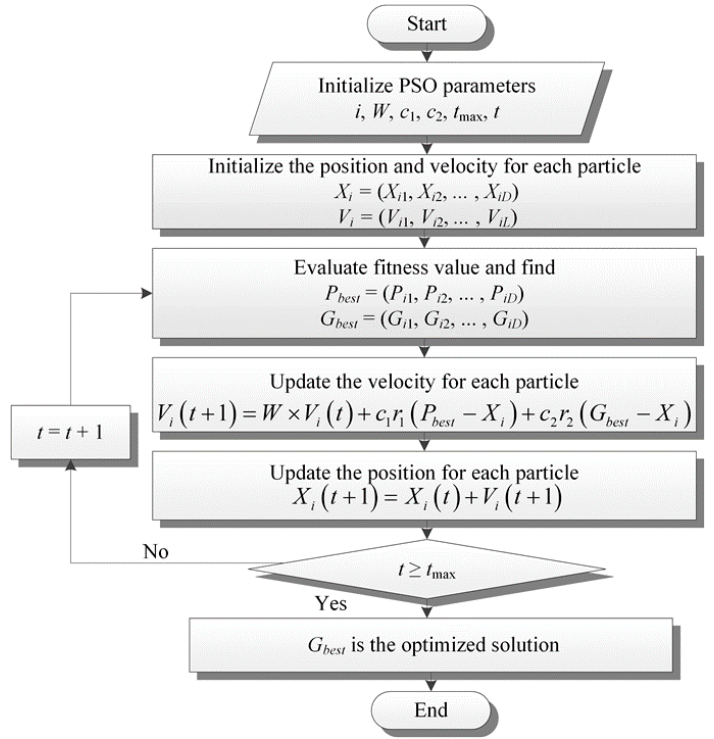
Figure 2. Flow chart of particle swarm optimization (PSO) algorithm.